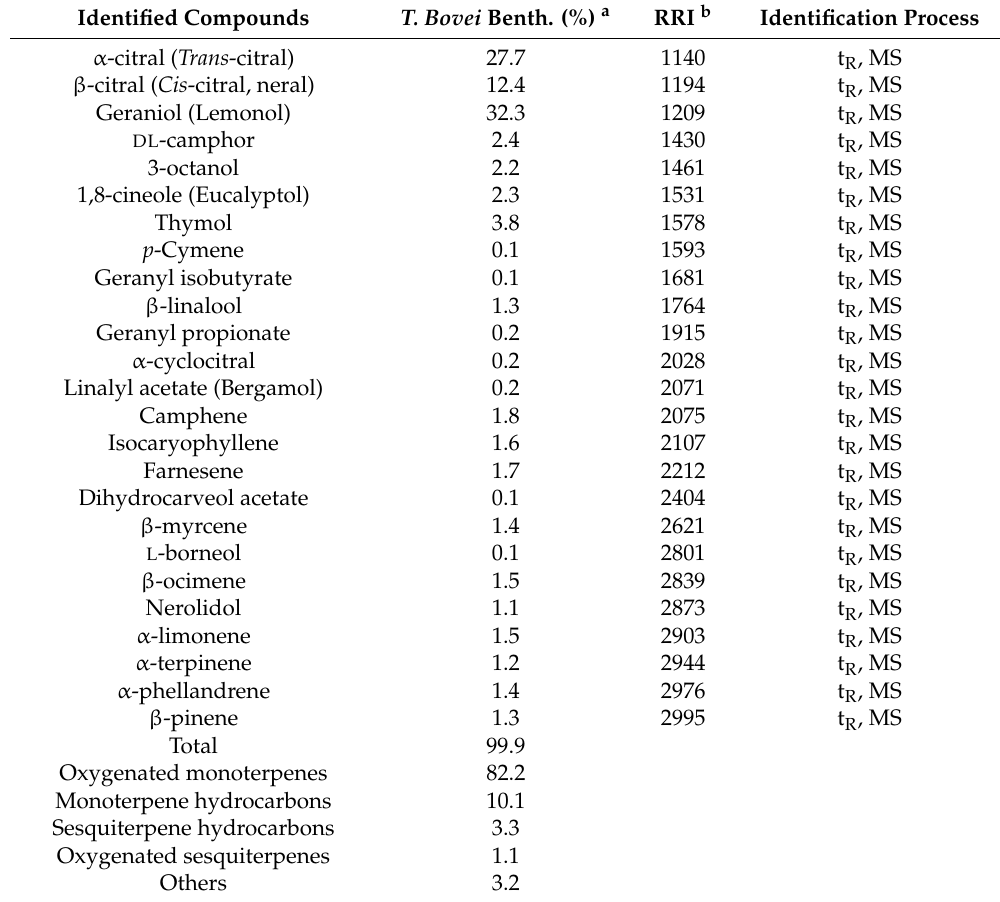
Table 1. The metabolic profile of